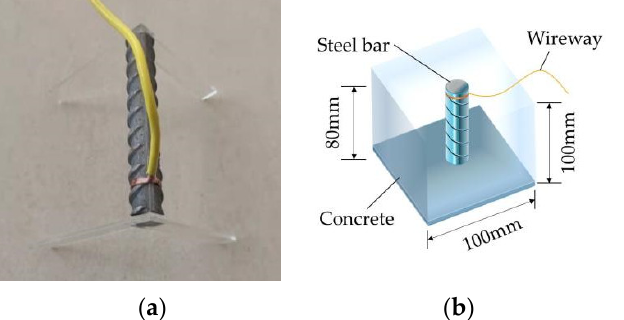
Figure 1. Schematic diagram of erection reinforcement. ( a ) Erection reinforcement; ( b ) Three di- mensional schematic diagram of test piece.